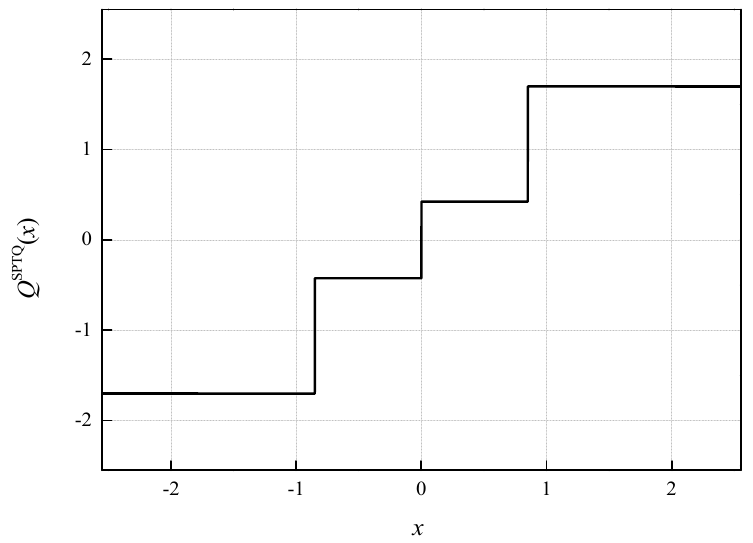
Figure 2. Transfer characteristic of two-bit SPTQ Q SPTQ ( x ) for [- x maxSPTQ , x maxSPTQ ] = [-2.5512, 2.5512]. To determine the total distortion of our symmetrical two-bit SPTQ, composed of the granular and the overload distortion, D SPTQ = D SPTQ g + D SPTQ